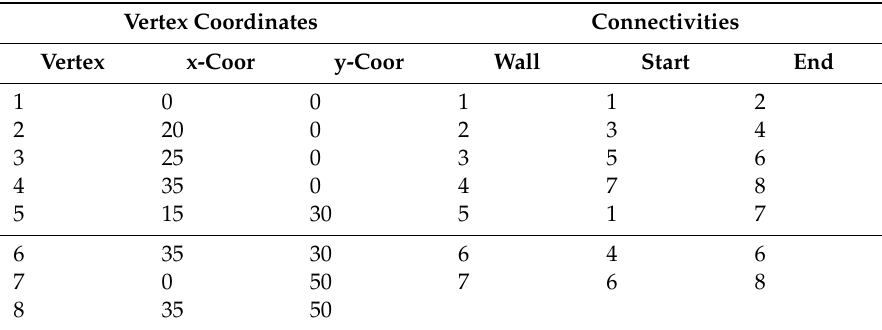
Table 2. Joint coordinates and wall start / end points. Example 1 with seven walls.